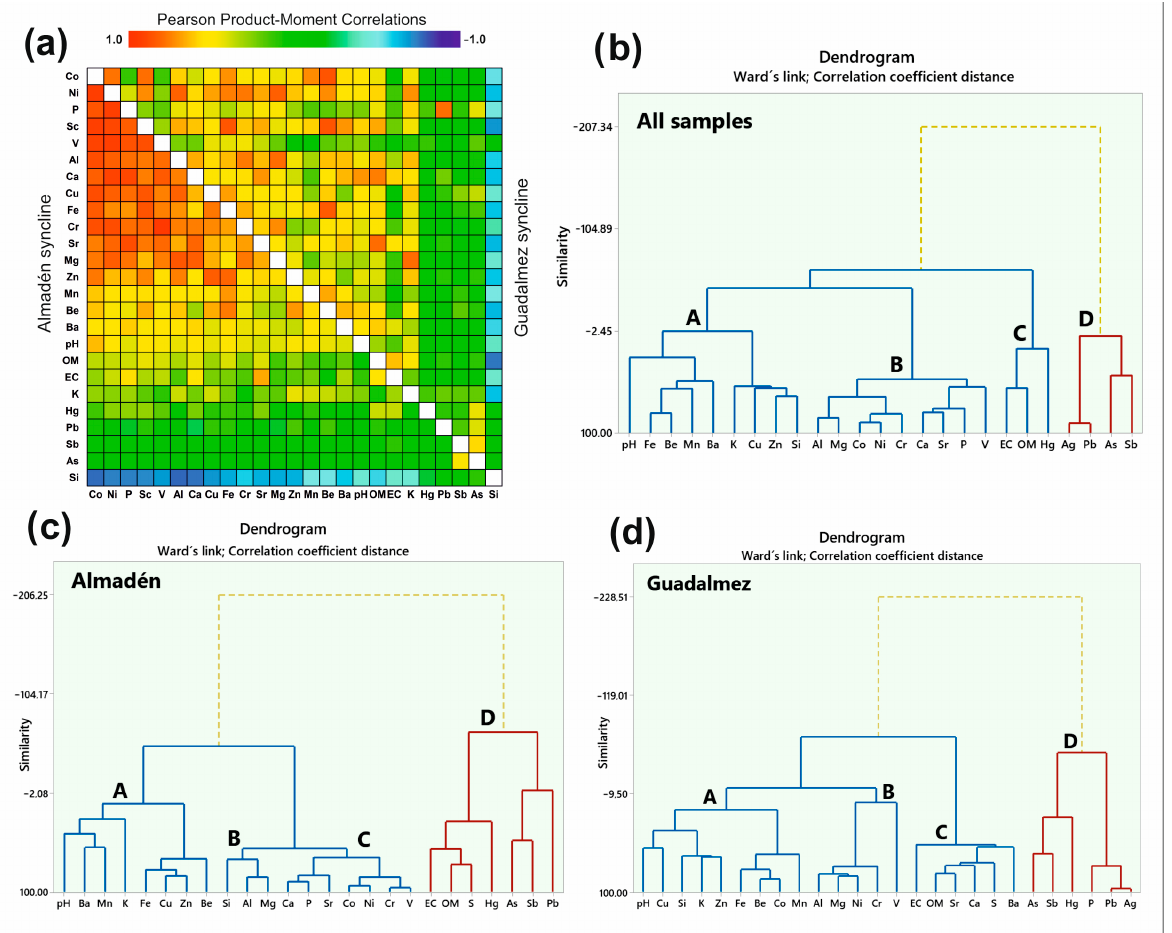
Figure 3. ( a ) Correlation matrix for the Almadén and Guadalmez synclines and dendrograms for all samples ( b ), Almadén syncline ( c ), and Guadalmez syncline ( d ). A–D correspond to the different subgroups obtained.